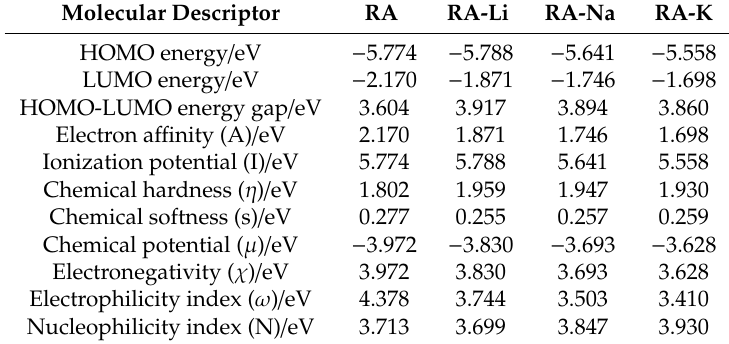
Table 3. Energy of HOMO/LUMO orbitals and other reactivity descriptors.